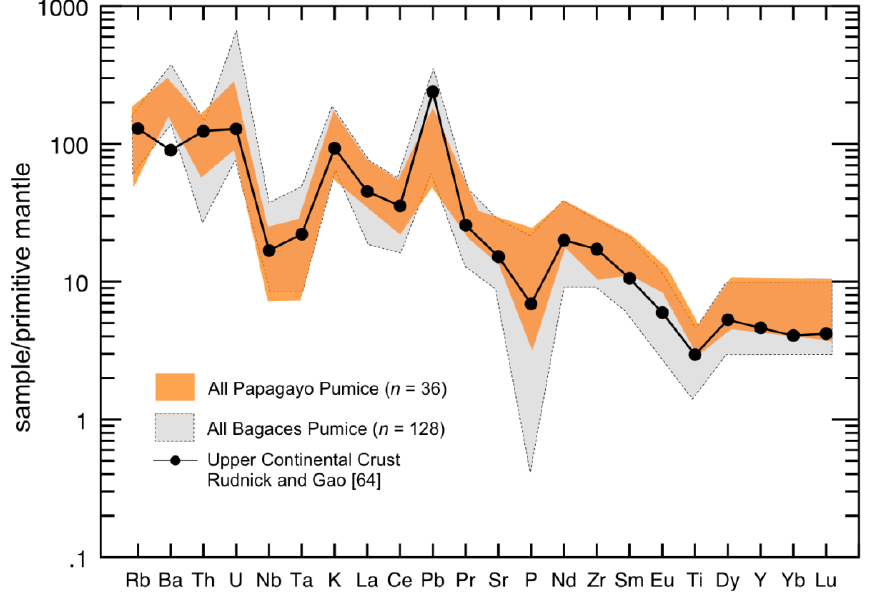
Figure 16. Spider diagram of incompatible elements for samples of the Papagayo Tuff ( n = 36) and all units of the Bagaces Formation ( n = 128). The average composition of the upper continental crust as given by Rudnick and Gao [64] is shown by the dashed line. Data for the Bagaces Formation from Szymanski